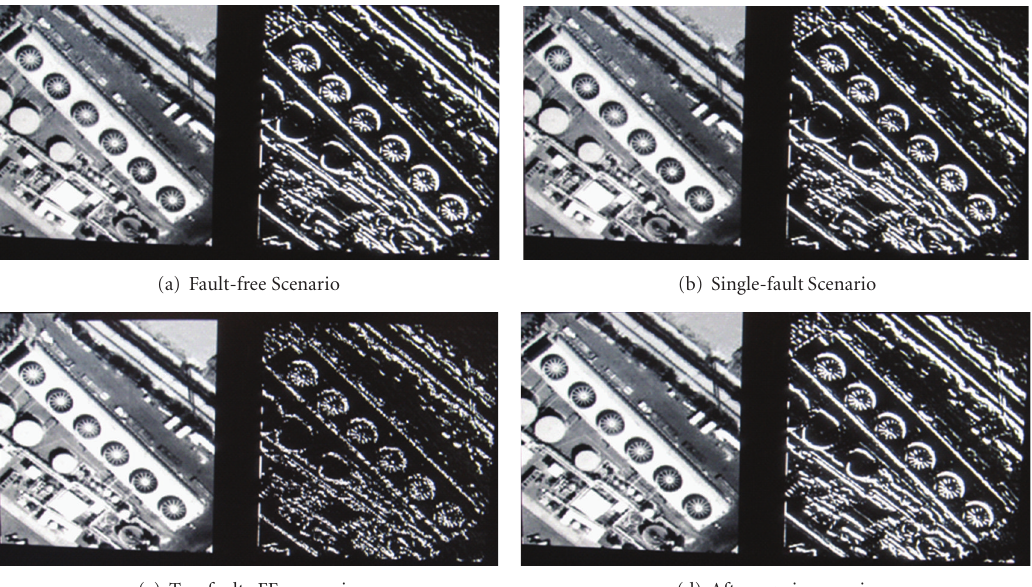
Figure 9: Original and edge-detected images.